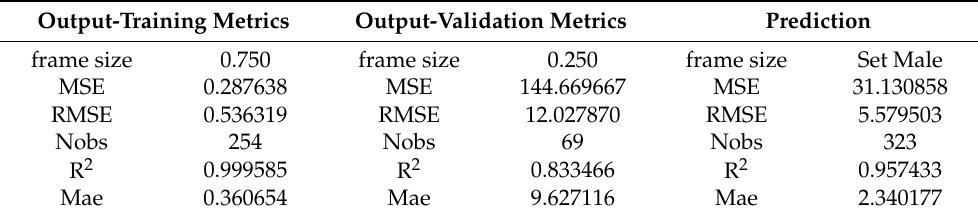
Table 5. Parameters of the generated model—age assessment for men.